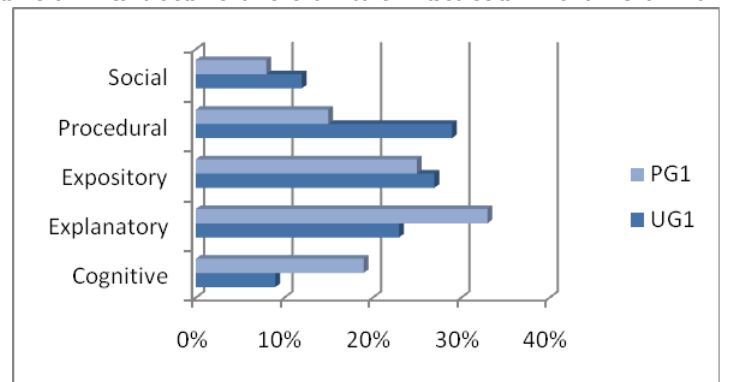
Figure 4: Dimensions of Interactions in the Online Discussion Forums in WawasanLearn